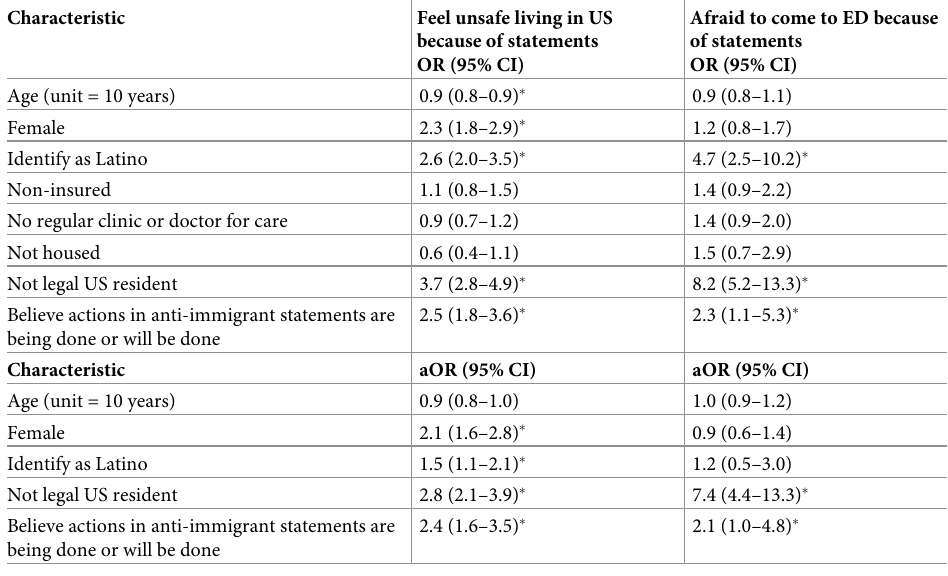
Table 3. Association of characteristics with primary outcomes of feeling unsafe in the US and feeling afraid to come to the ED because of the president’s anti-immigrant statements: ORs and aORs.